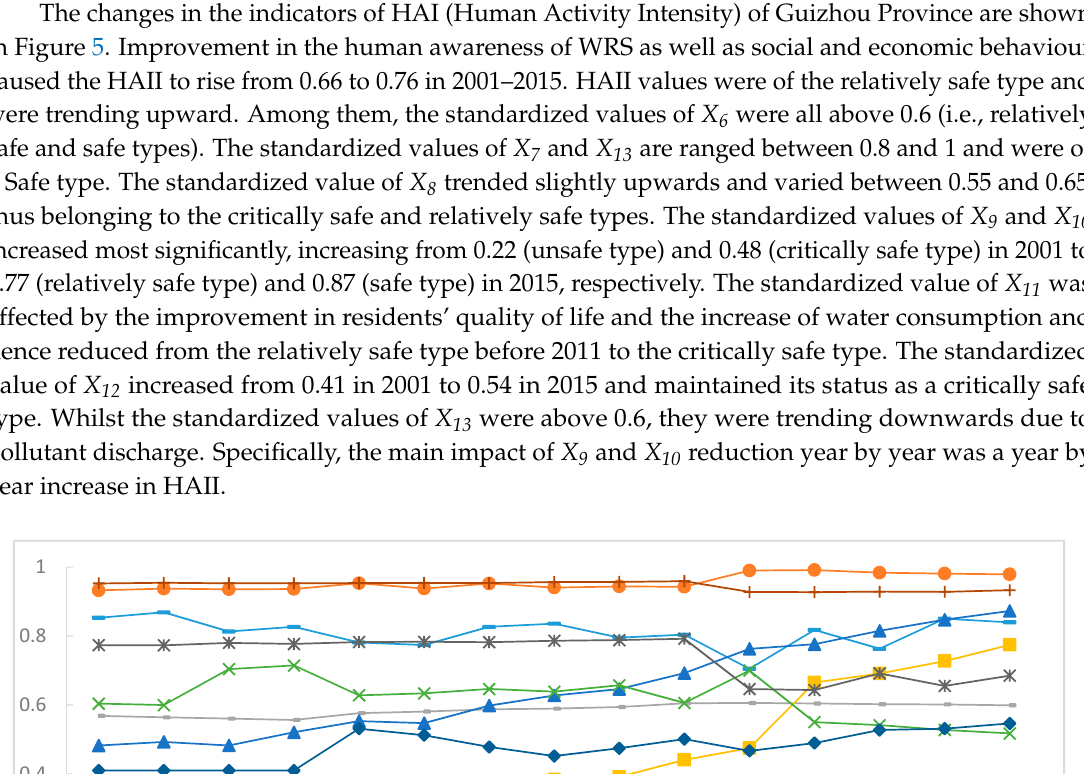
Figure 4. Changes in WRBC (Water Resources Background Conditions) indicators of Guizhou Province in 2001–2015.